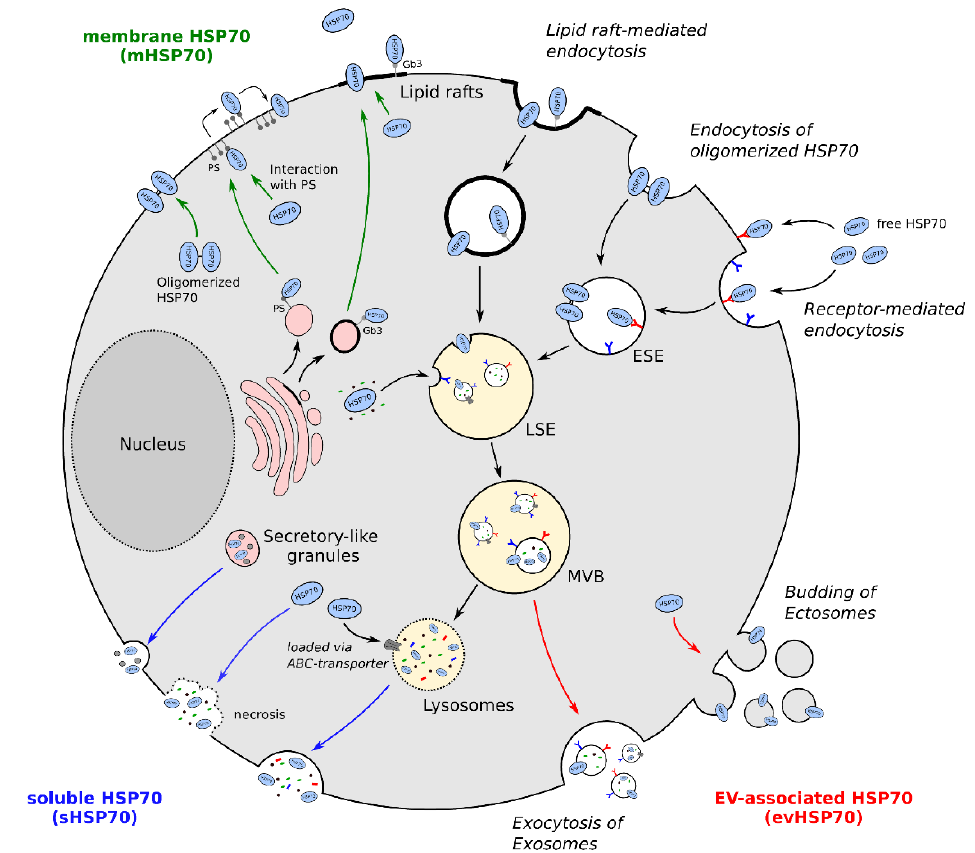
Figure 1. Translocation of extracellular HSP70 (exHSP70). Cellular stress leads to the translocation of HSP70 via different potential mechanisms. In particular, membrane-associated HSP70 (mHSP70, green) can be found in lipid rafts, mainly interacting with globotriaosylceramide 3 (Gb3). Moreover, HSP70 can interact with phosphatidylserine (PS), leading to its integration into the plasma membrane. Oligomerized HSP70 was also reported to integrate into the plasma membrane directly. HSP70 can also be released into or onto extracellular vesicles (evHSP70, red), by either budding of the plasma membrane (ectosomes) or by an endolysosomal pathway (exosomes). Soluble HSP70 (sHSP70, blue) can be secreted either passively during cell necrosis or actively via secretory granules or lysosomes. ESE: early sorting endosomes; LSE: late sorting endosomes; MVB: multivesicular bodies; EV: extracellular vesicles; PS: phosphatidylserine; Gb3: globotriaosylceramide 3; HSP70: heat shock protein 70 .